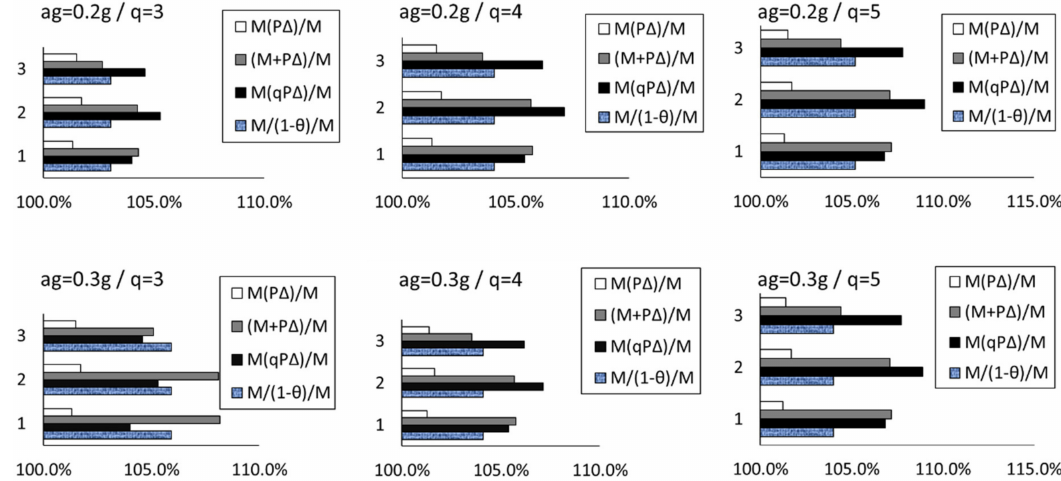
Figure 9. Influence of the q factor and ground acceleration in the P - ∆ e ff ect of three-story steel resisting frame structure. Illustration of di ff erent approaches for the estimation of the maximum acting moment in the story